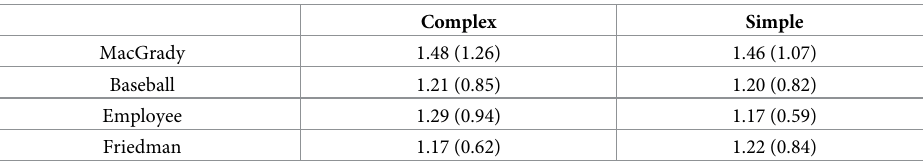
Statistics represent mean(standard